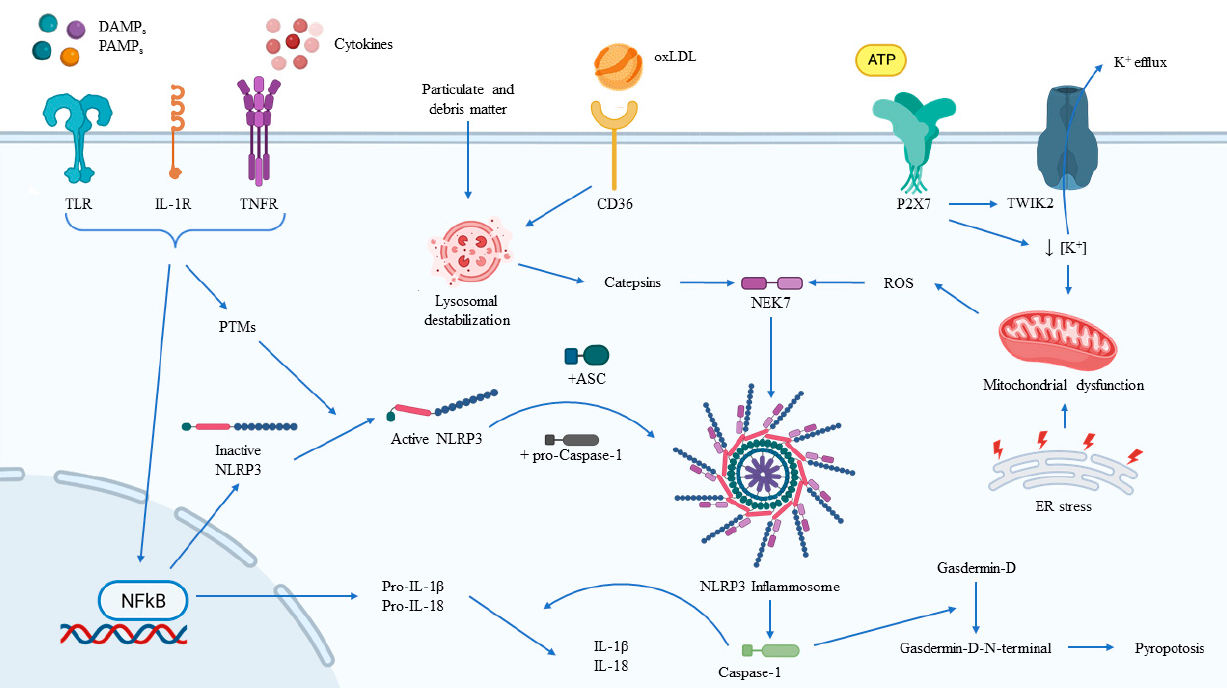
Figure 2. Regulation of NLRP3 inflammasome activation. The main external and intracellular factors involved in the activation and modulation of the NLRP3 inflammasome, together with its main effects. ASC, adaptor apoptosis-associated speck-like protein containing a caspase-recruitment domain; ATP, adenosine triphosphate; DAMPs, damage/danger-associated molecular patterns; ER, endoplasmic reticulum; IL-1R, interleukin-1 receptor; NFkB, nuclear factor-kB; NLRP3, nucleotide-binding oligomerization domain-like receptor family pyrin domain containing 3; oxLDL, oxide low-density lipoprotein; PAMPs, pathogen-associated molecular pa tt erns; PTMs, post-translational modi fi cation; TLR, toll-like receptor; TNFR, tumor-necrosis factor receptor.